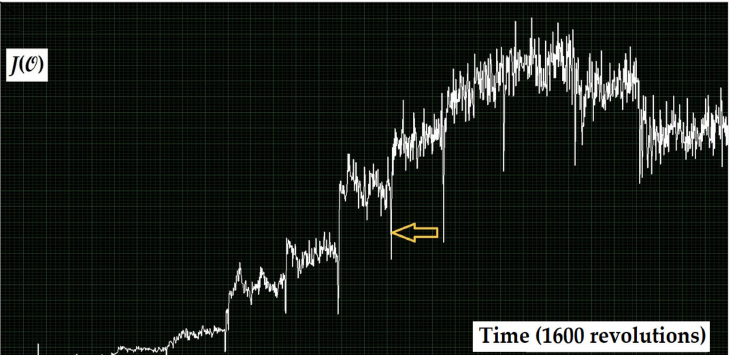
Figure 7. Time record of a not strongly averaged cavitation-intensity estimate acquired by the sensor